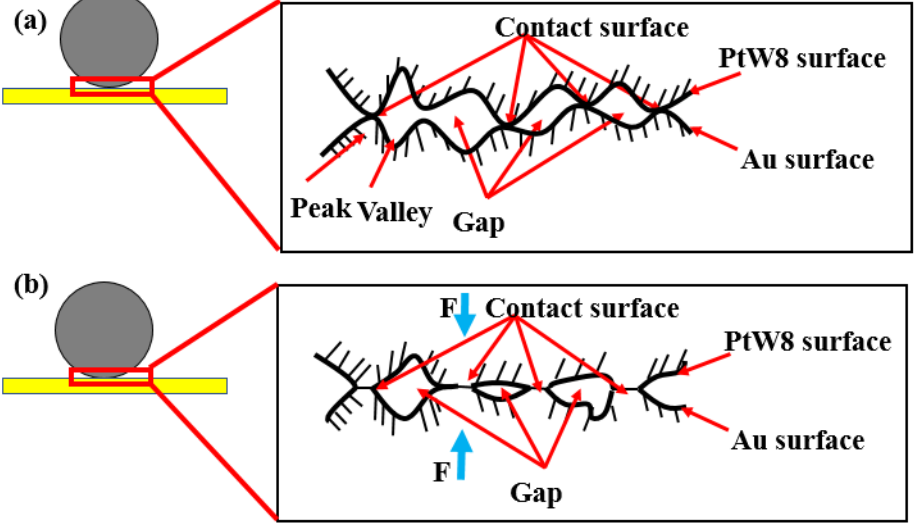
Figure 8. Influence of the force on the bonding interface: ( a ) not pressurized and ( b ) pressurized.